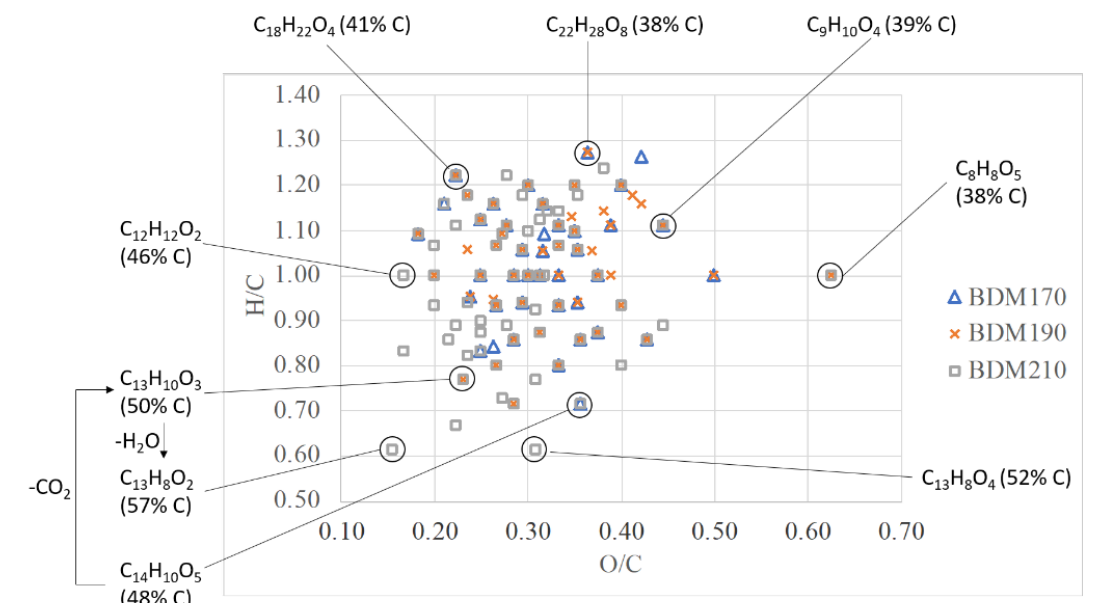
Figure 3. A van Krevelen plot including the m/z values of lignin-derived phenolic compounds identified in the BDM170, BDM190, and BDM210 samples with the chemical formula and the relative carbon content of selected identified m/z values. The lignin-derived aromatic compounds identified in the 2BDM190 sample show